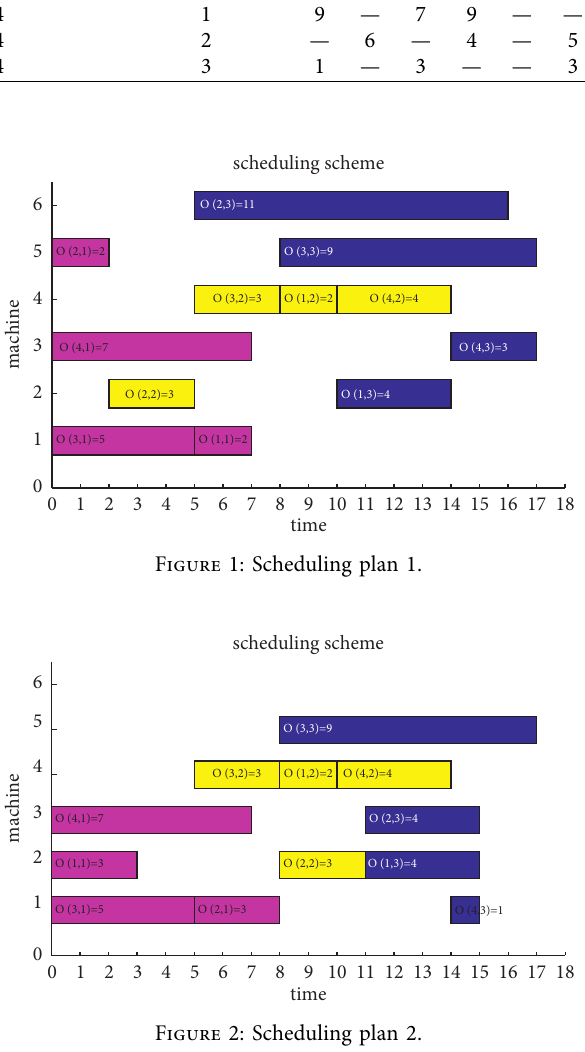
Figure 2: Scheduling plan